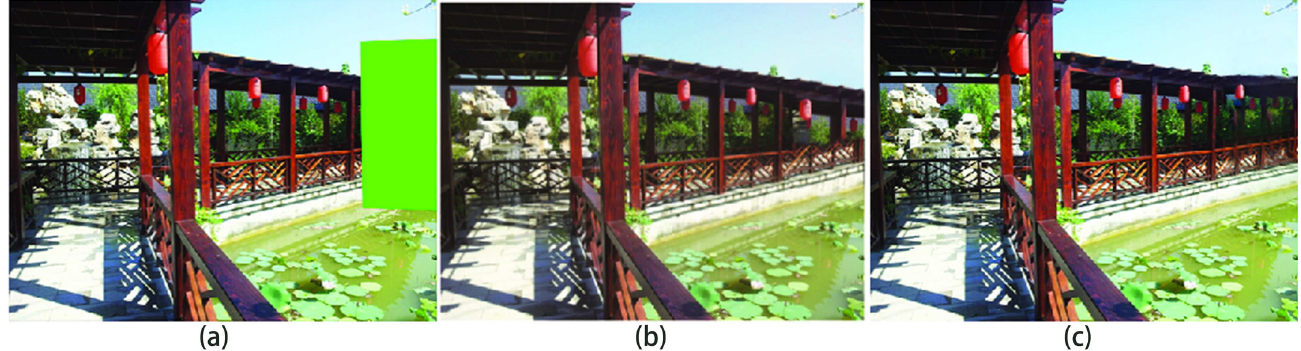
Fig 2. Depth for image completion: (a) input image, (b) results of the Barnes method [12], (c) results of our method.